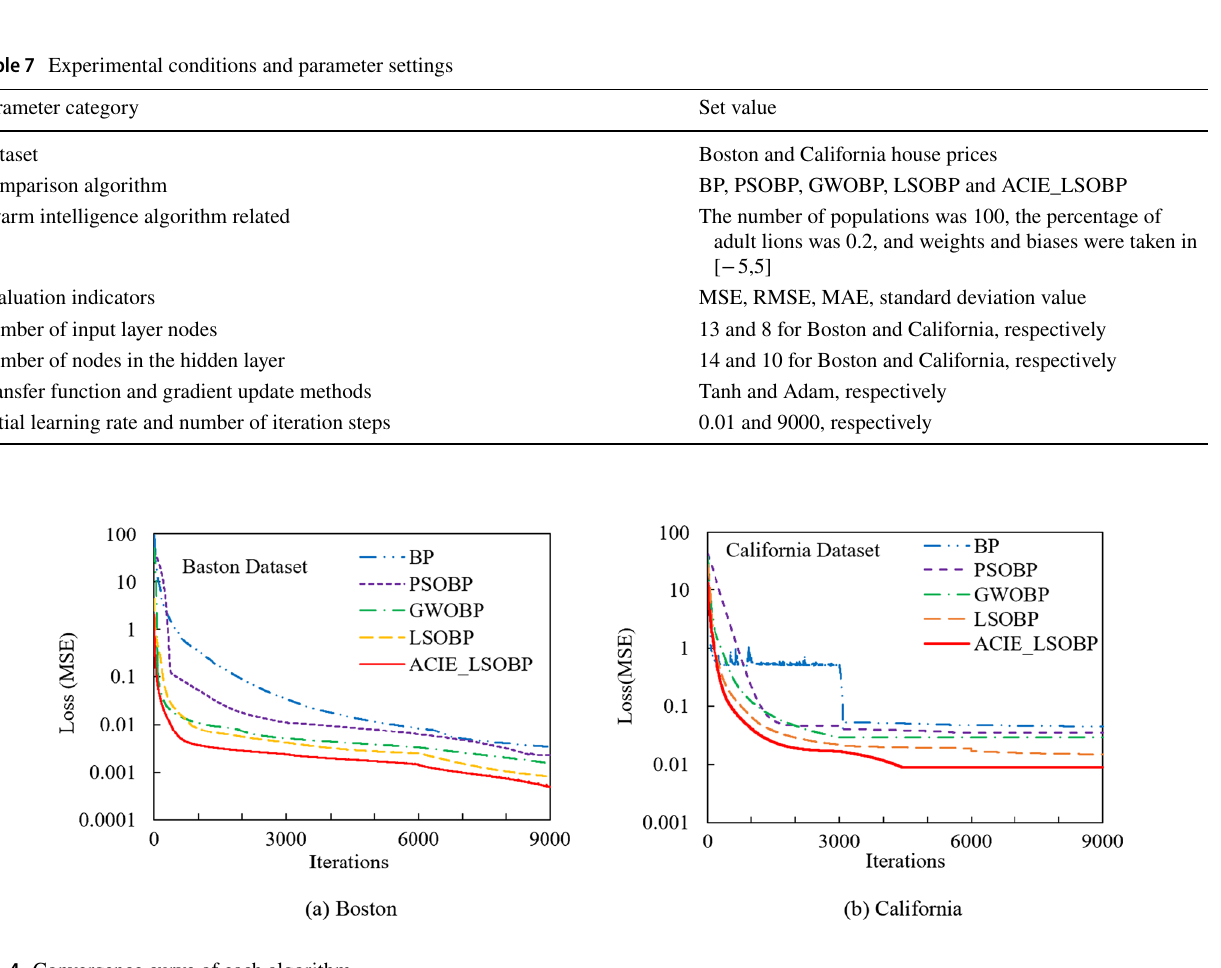
Fig. 4 Convergence curve of each algorithm Table 8 Final training error and deviation value of each method on the Boston house price